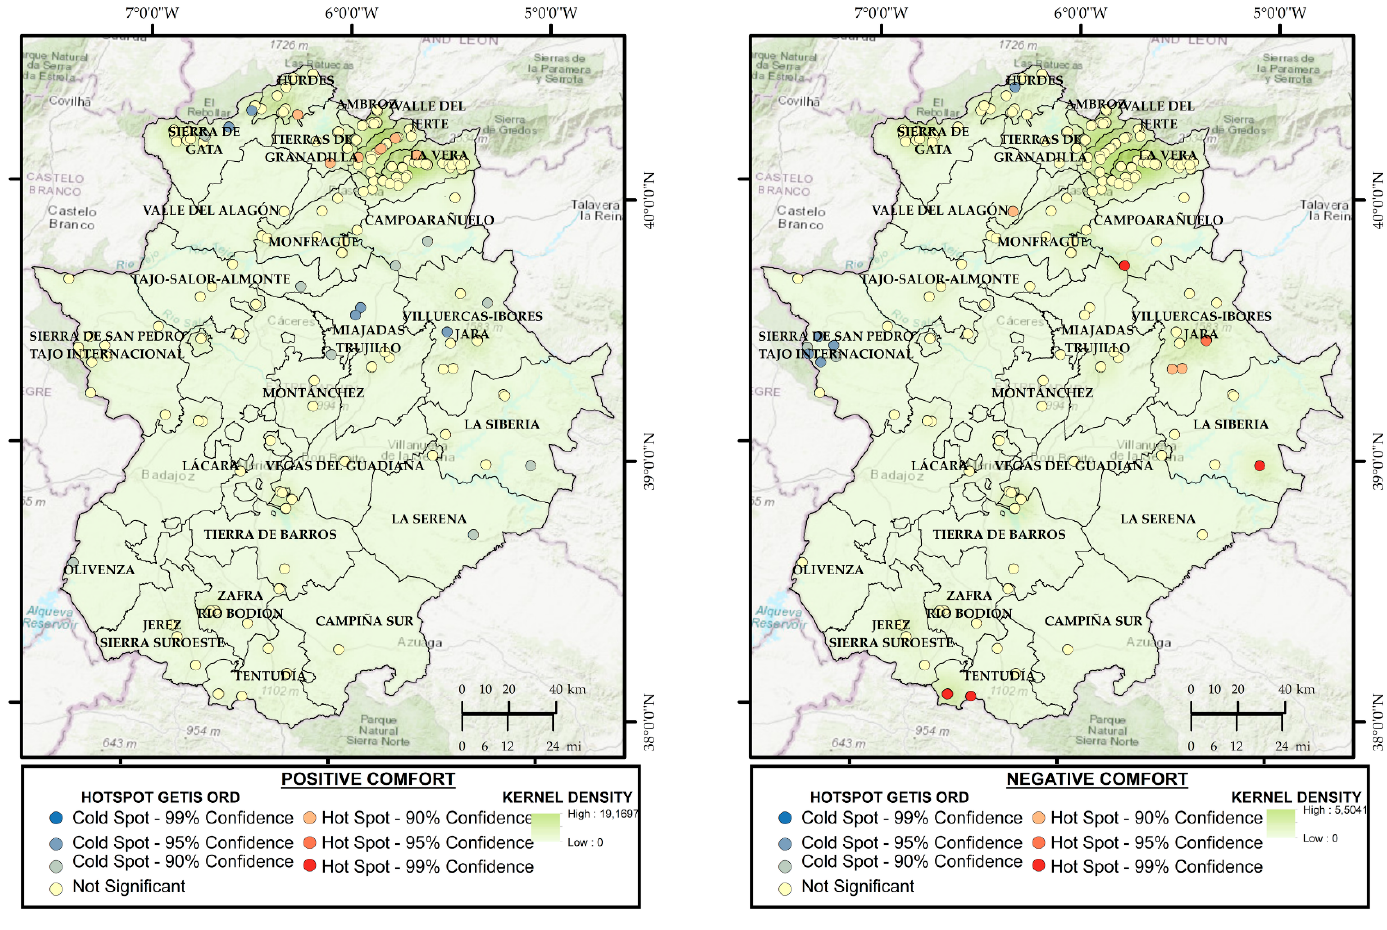
Figure 8. Gi* Comfort Positive (a) and Negative (b) mentions.